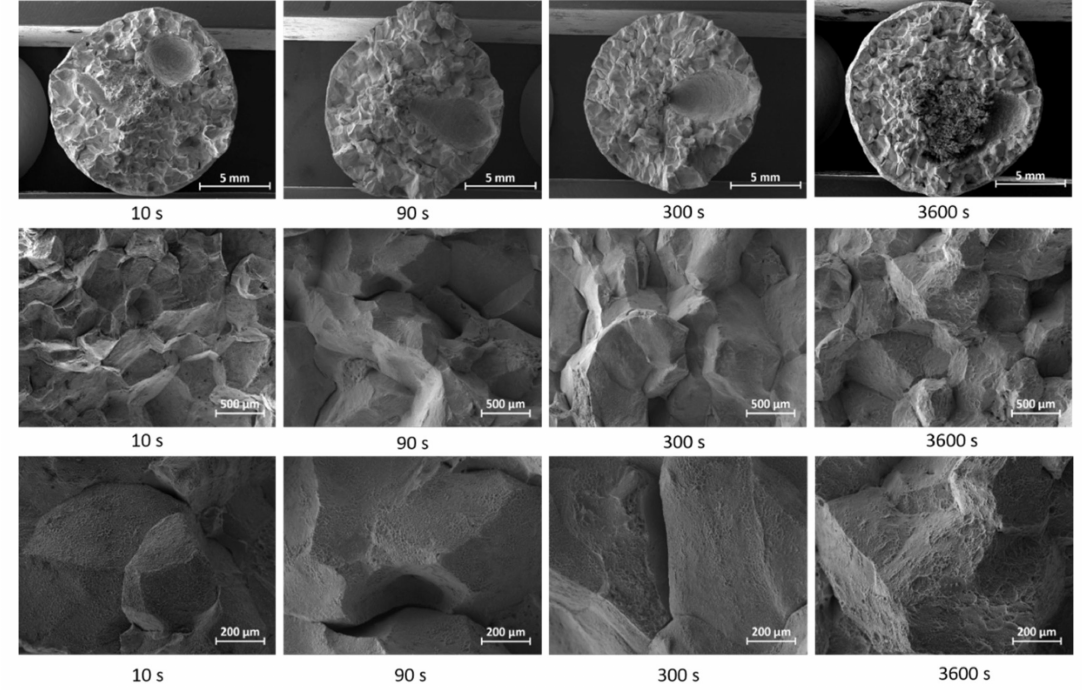
Figure 7. SEM images with 15 × , 100 × , and 250 × magnification for the samples tested at 750 ◦ C and different holding